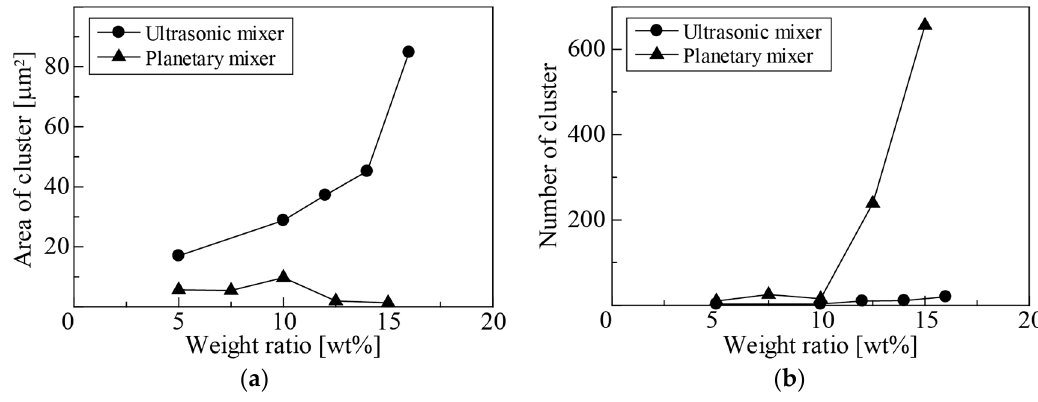
Figure 6. Evaluation of diffusion of magnetic particles in photosensitive composite: ( a ) Cluster area, and ( b ) number of clusters with respect to the change in weight ratio of magnetic particles.